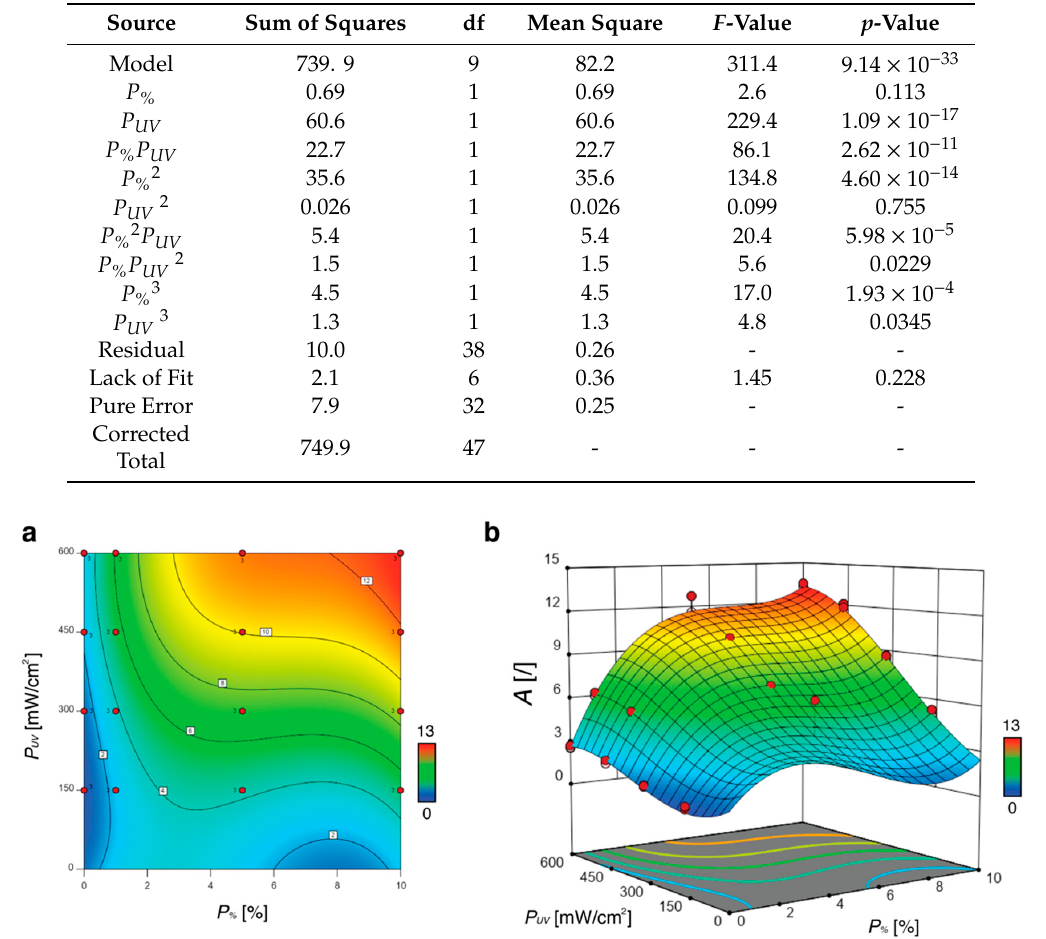
Table 6. ANOVA results for A value in the complete cubic model for photo-bending.